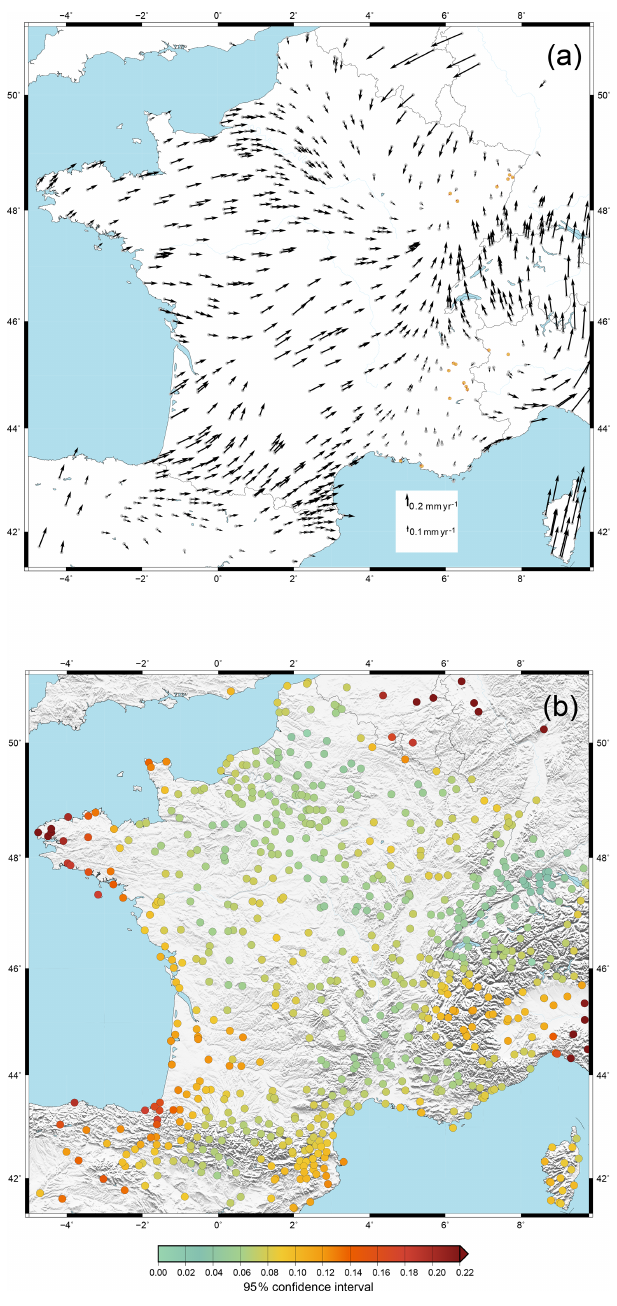
Figure 6. (a) Horizontal velocities for each site from Gaussian smoothing with (b) 95% confidence interval (CI95). In brown: hor- izontal velocities below the detection level based on the synthetic